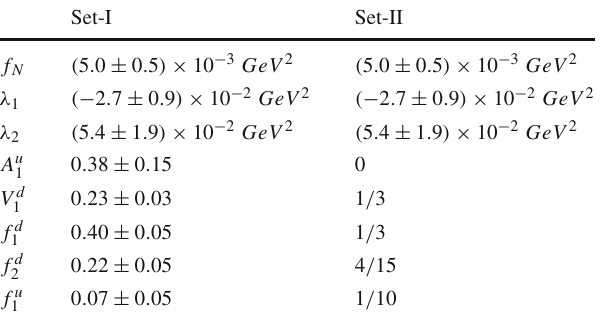
Table 1 The numerical values of the main input parameters entering the expressions of the nucleon’s DAS Set-I